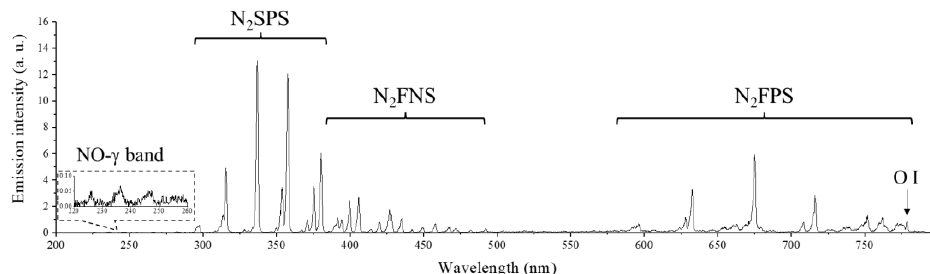
Figure 2. Optical emission spectrum of plasma on the RDBD surface.